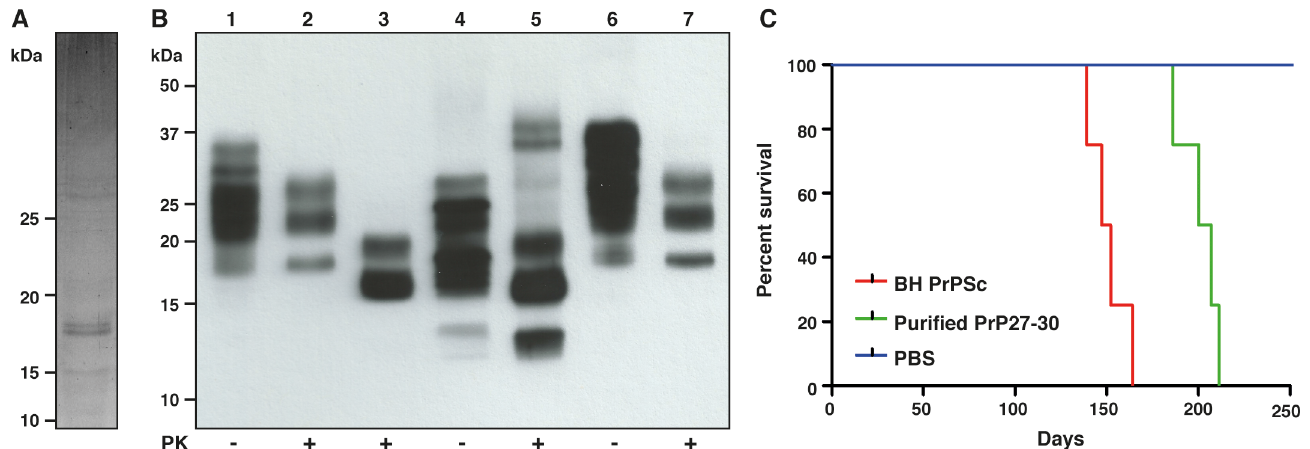
Fig 1. Characterization of GPI-anchorless prions. ( A ) SYPRO Ruby-stained 15% SDS-PAGE of purified GPI-anchorless PrP 27 – 30. The molecular mass of the purified peptide (residues 89 – 232) is 17,148 Da. The doublet seen at ~17 kDa reflects the presence of PK-resistant fragments of slightly different sizes ( “ ragged ends ” [18]). Faint bands of ~34 kDa are characteristic dimers, the result of an incomplete dissociation of PrP 27 – 30 fibrils. Minor impurities correspond to traces of ferritin, tubulin and collagen [23], which are clearly recognizable in electron micrographs. ( B ) Western blot of: Lanes 1 – 2, RML-infected WT mouse brain homogenate (BH), ± PK digestion. WT PrP presents as three characteristic bands of di-, mono-, and unglycosylated protein, respectively. Lanes 3 – 4, RML-infected GPI-anchorless PrP transgenic mouse BH, ± PK digestion; lane 5, purified GPI- anchorless PrP 27 – 30, used for cryo-EM studies; the 10 – 15 kDa band corresponds to a minor population of N-terminally truncated PK-resistant fragments described by Vázquez-Fernández et al. [18]; lanes 6 – 7, WT mouse BH inoculated with purified GPI-anchorless PrP 27 – 30, ± PK digestion. ( C ) Kaplan-Meier survival analysis of: WT mice infected with GPI-anchorless PrP Sc BH (red), survival time 153 ± 10 days (standard deviation); WT mice infected with purified GPI-anchorless PrP 27 – 30 (green), survival time 203 ± 9 days (standard deviation); WT mice inoculated with PBS as negative control (blue) (n = 6, P < 0.05, Gehan-Breslow-Wilcoxon test).